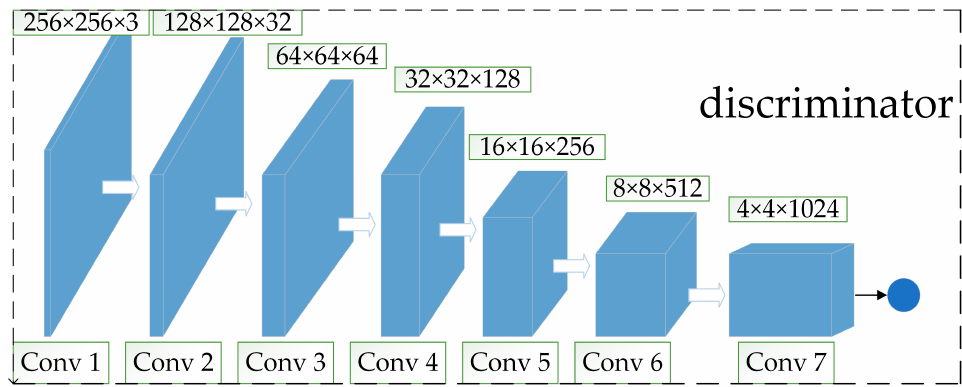
Figure 7. Improved discriminator.